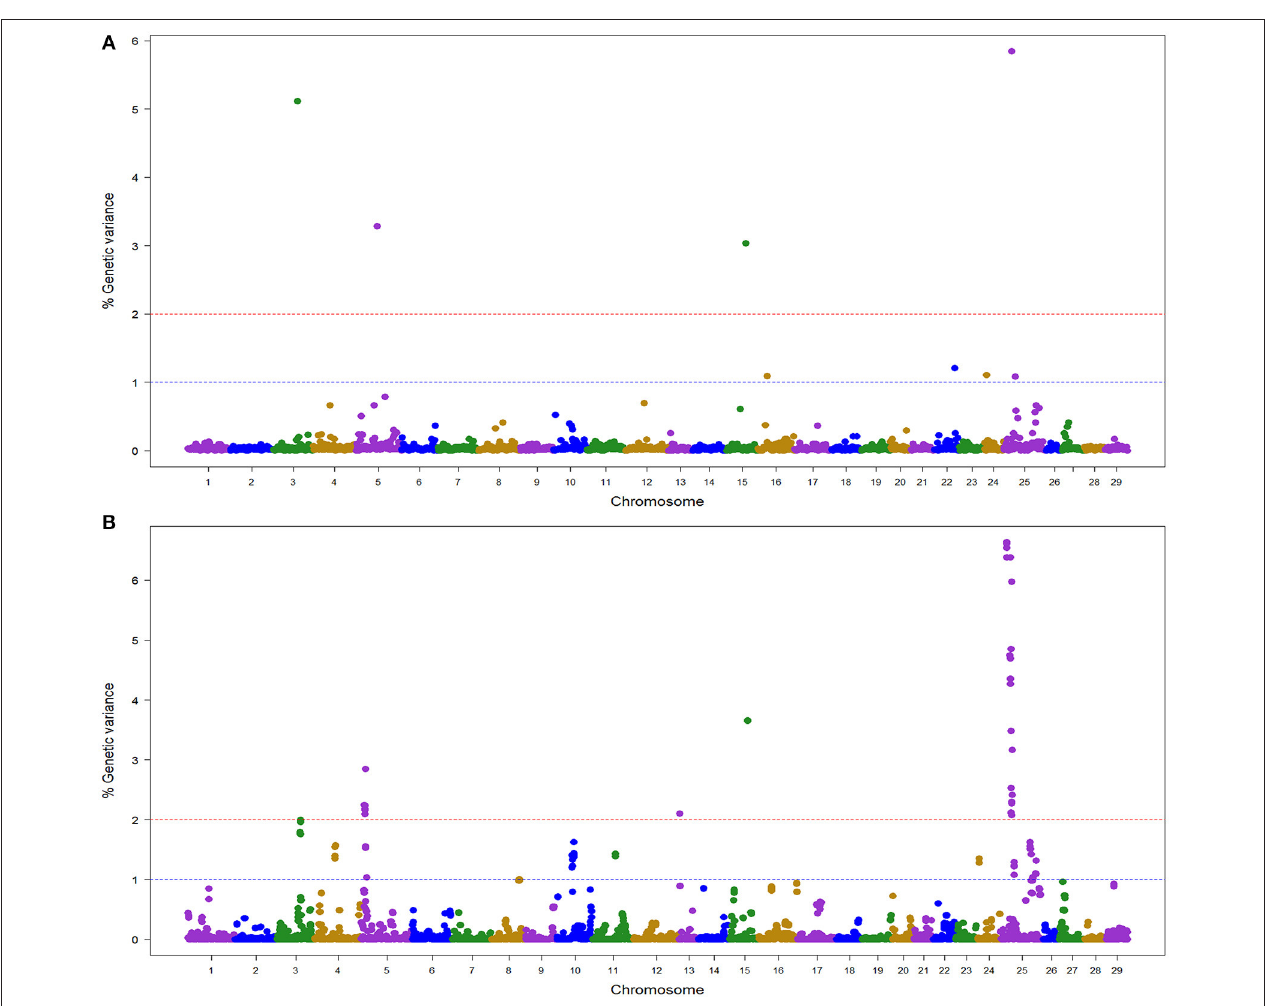
FIGURE 3 | Manhattan plot showing the association between SNP genomic windows and BCWD resistance in NCCCWA sample genotyped with the RAD-SNPs: (A) GWAS for STATUS performed with BayesB using 1Mb exclusive windows. (B) GWAS for STATUS performed with wssGBLUP using 1Mb sliding windows.